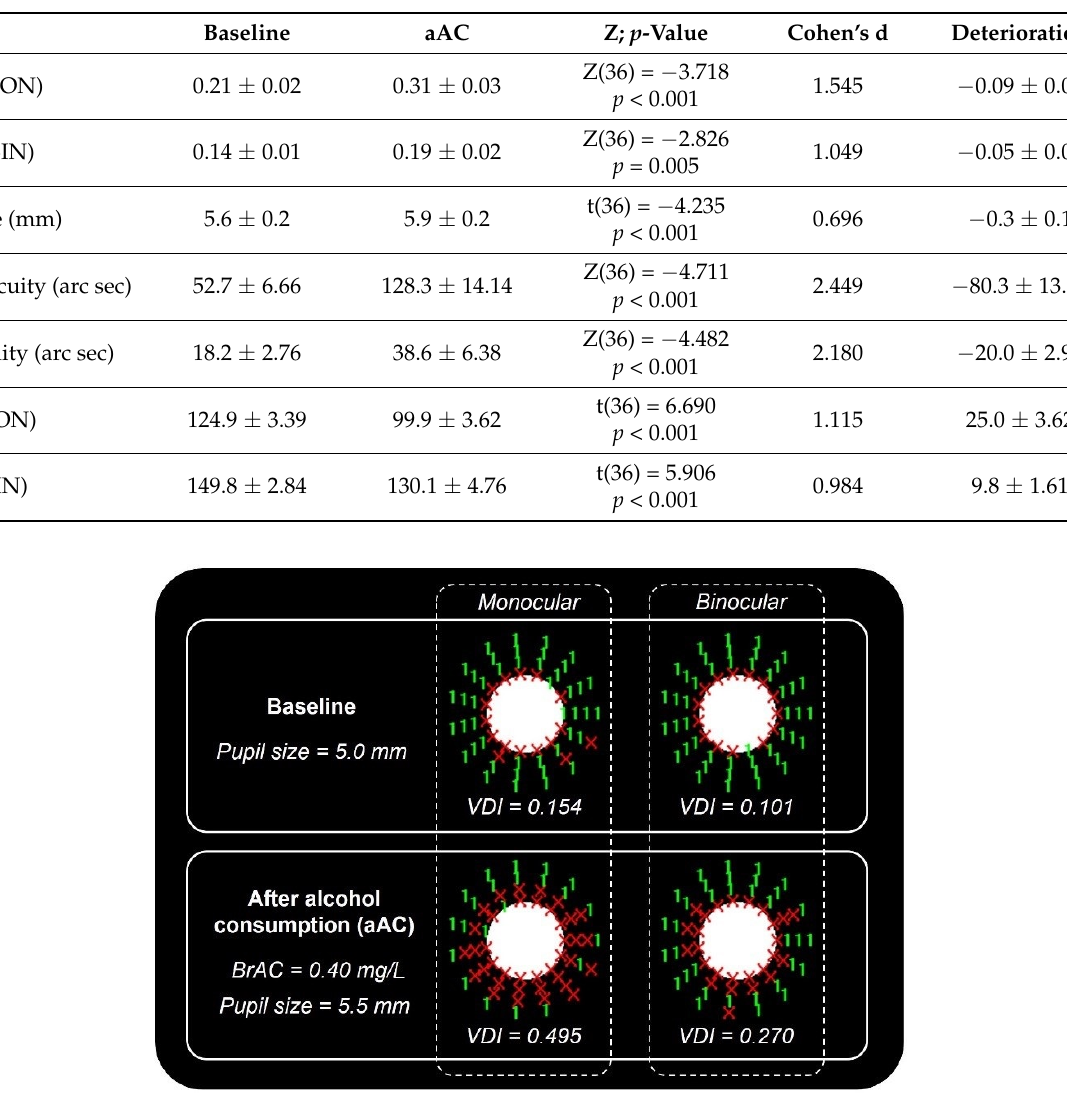
Figure 1. Graphic monocular and binocular results for the VDI and pupil size of one of the participants in both experimental conditions (baseline and aAC). The red symbols (X) correspond to peripheral stimuli not detected by the subject, revealing the shape of the halo.